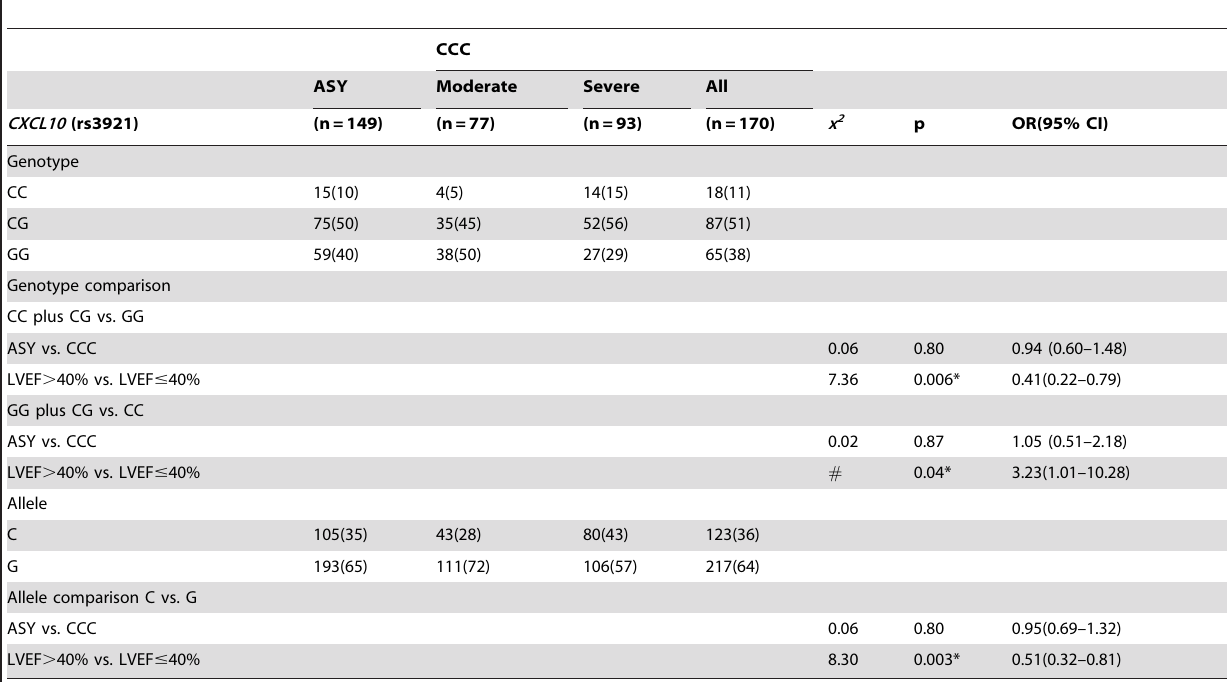
Table 3. Genotype and allele frequencies for the CXCL10 rs3921 polymorphism in patients with Chagas